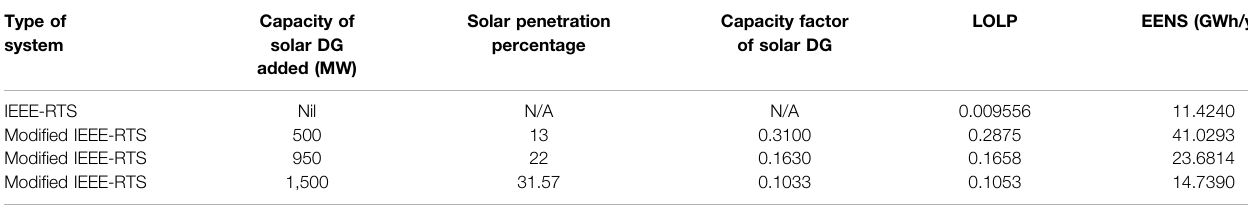
TABLE 6 | Reliability indices for the proposed